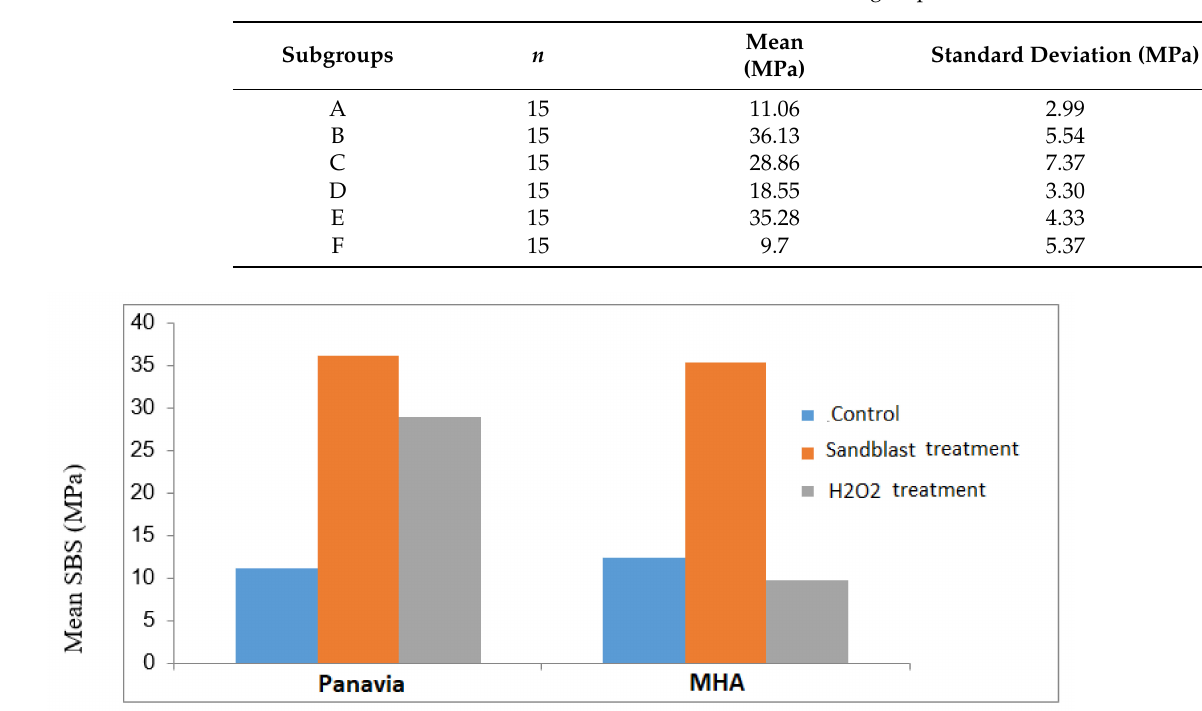
Table 2. Mean and standard deviation of the SBS in six different groups.